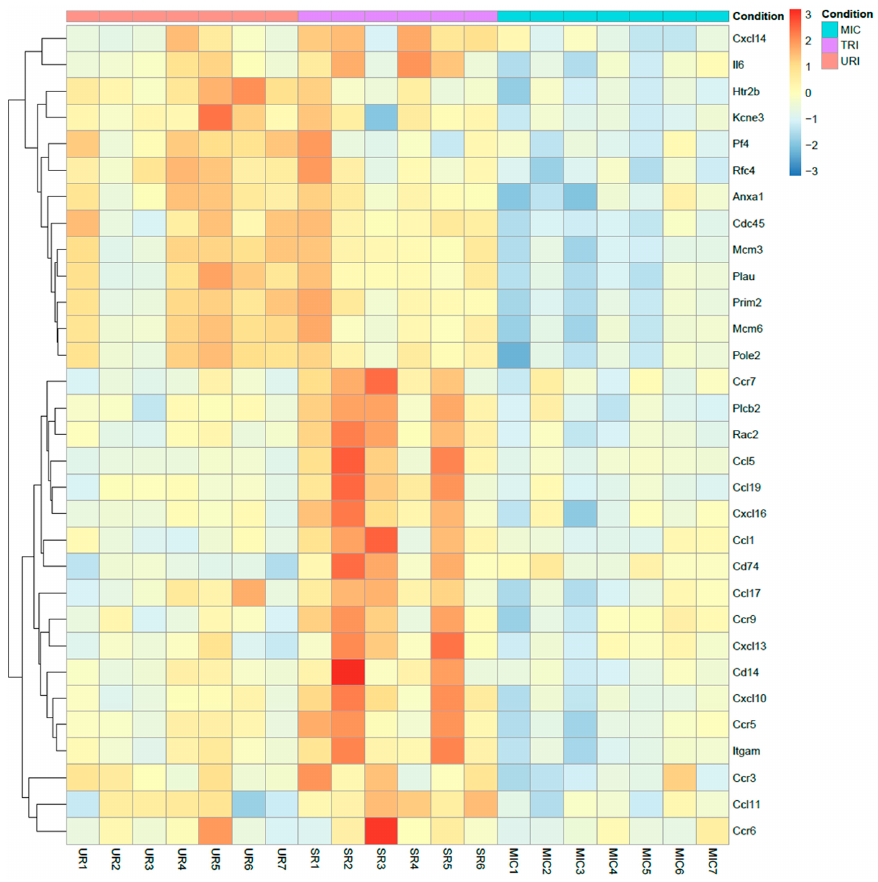
Figure 7. Heatmap of highly upregulated genes. TRI specific upregulated genes compared to MIC and URI using log 2 (foldchange) values ( q ≤ 0.05). Colors: Red-upregulated; yellow-neutral; blue-downregulated.